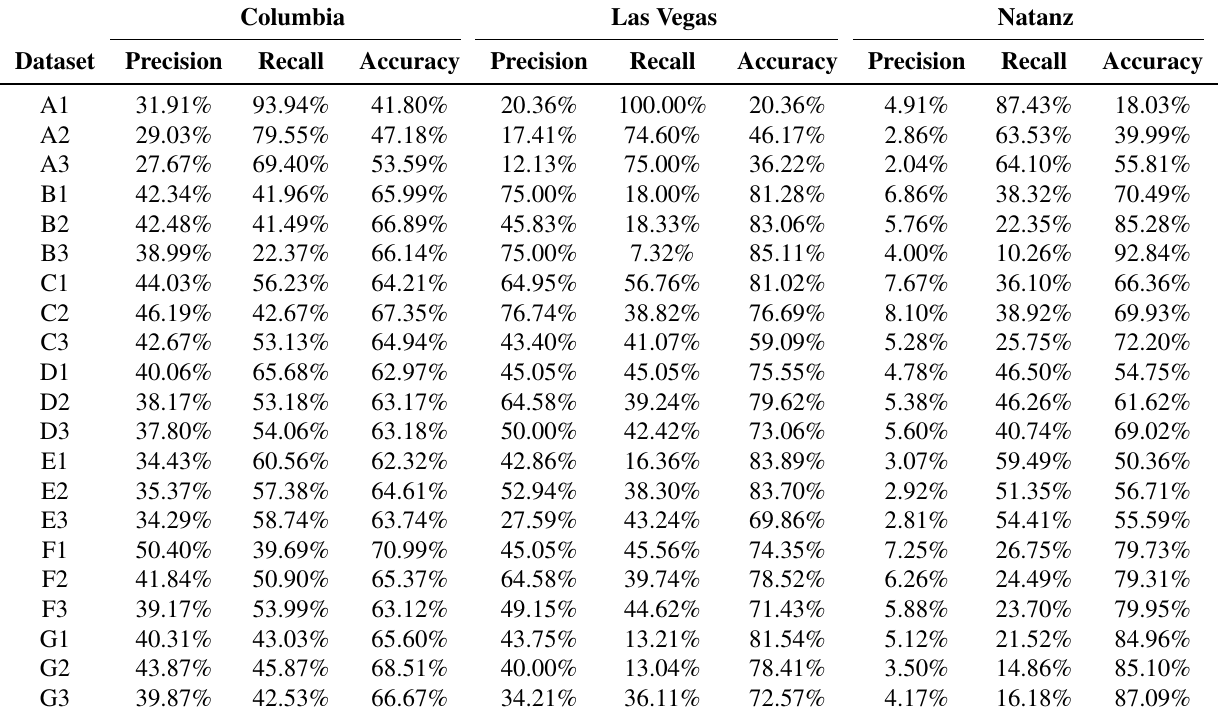
Table 10. Decision tree (CART) change prediction results.